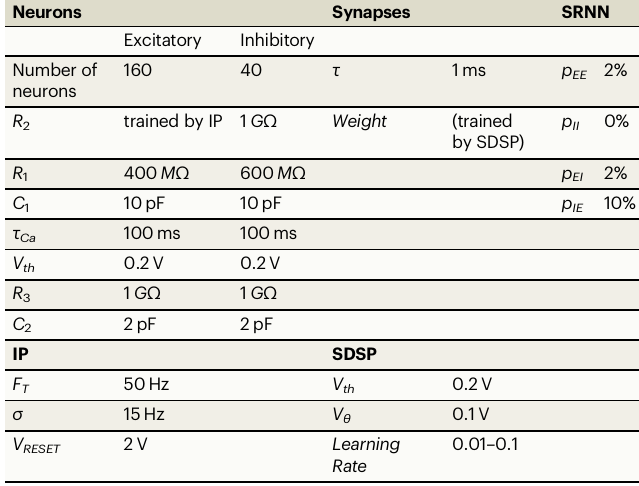
Table 1 | Parameter values for the initialization of the SRNN